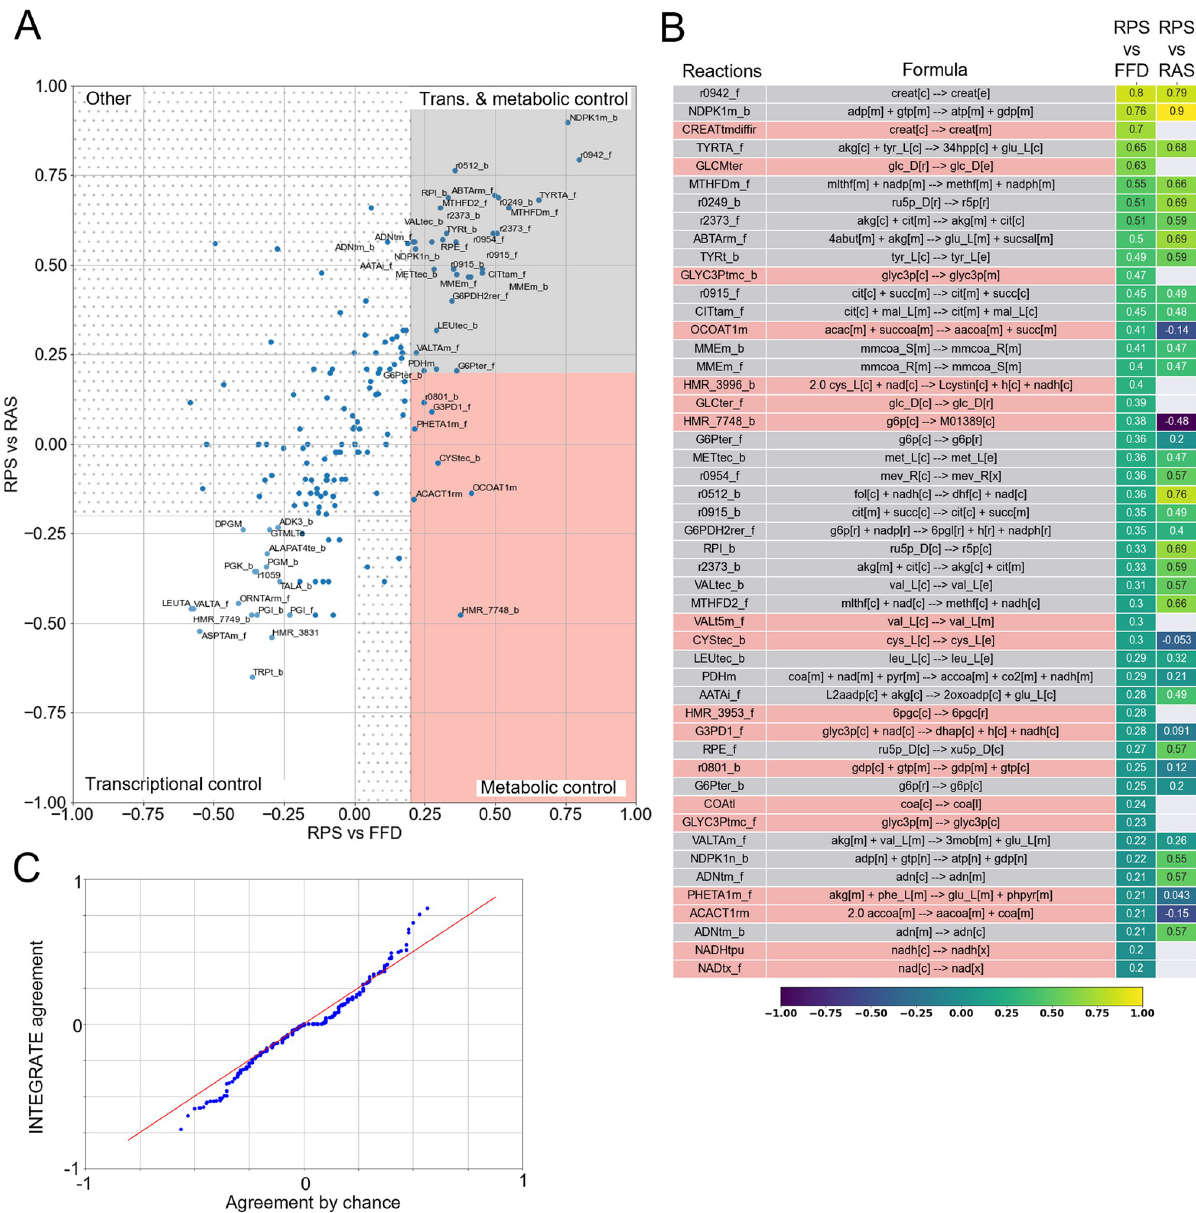
Fig 6. Variation concordance analysis for Recon3D. A) RPSvsFFD (x-axis) and the RPSvsRAS (y-axis) scores of the metabolic reactions for which quantification of all substrate abundances was available. We reported the names of the reactions having at least one of the scores greater than 0.2 (i.e. fair concordance). B) Heatmap showing the RPSvsRAS and the RPSvsFFD concordance scores, for reactions having a level of concordance between RPS and FFD greater than 0.2. C) Q − Q plot between the empirical probability of agreement between two independent datasets and INTEGRATE Cohen’s kappa distribution related to the comparison between RPS and